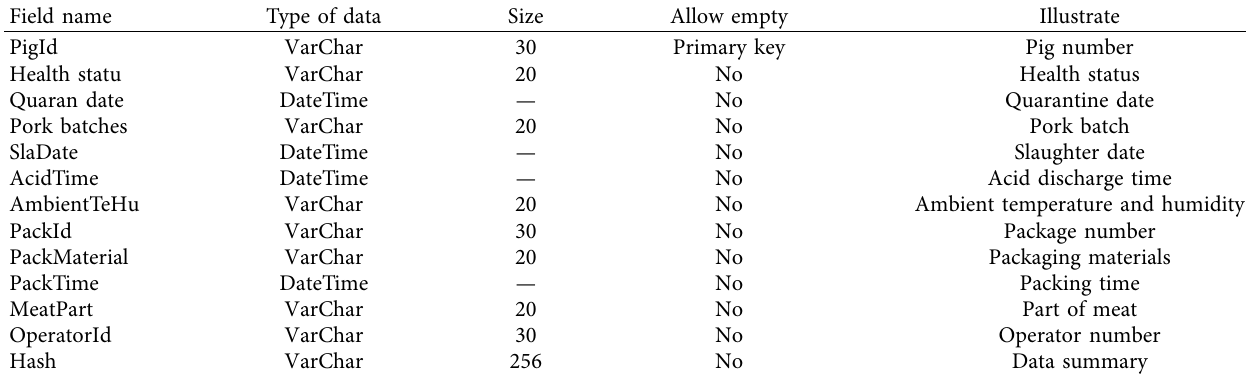
Table 4: Slaughter and processing information sheet.